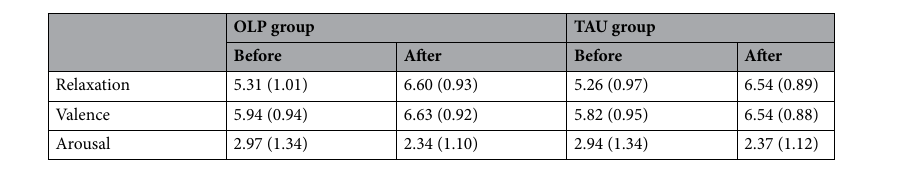
Table 1. Affective ratings (means, standard deviations) before and after the daily relaxation exercise. OLP open-label placebo, TAU treatment as usual (without placebo).